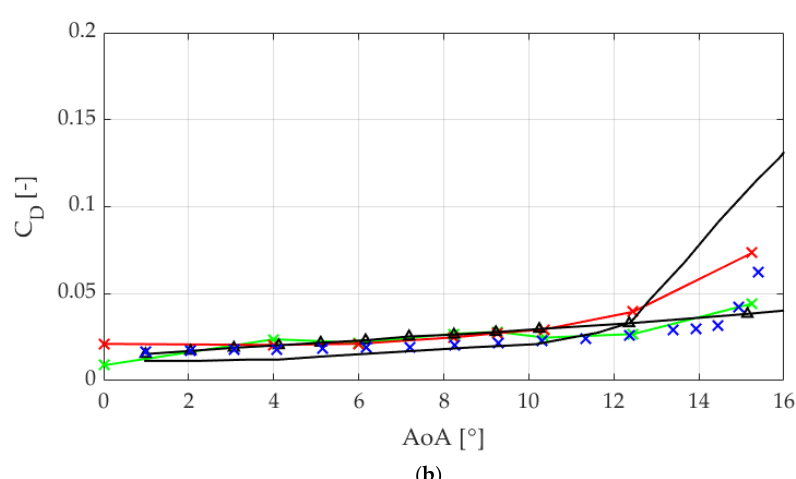
Figure 8. Representation of the influences of flow control devices on the ( a ) C L and ( b ) C D coefficient curves for the DU97W300 airfoil.